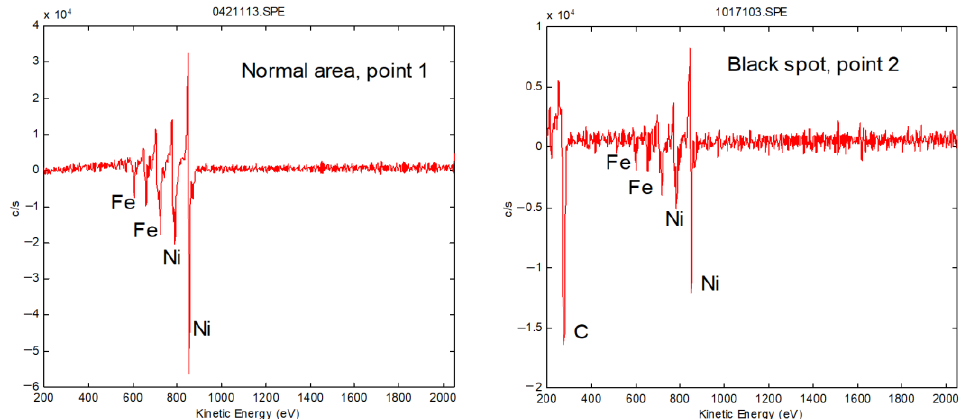
Figure 9. Auger electron spectra on normal area and black spot.